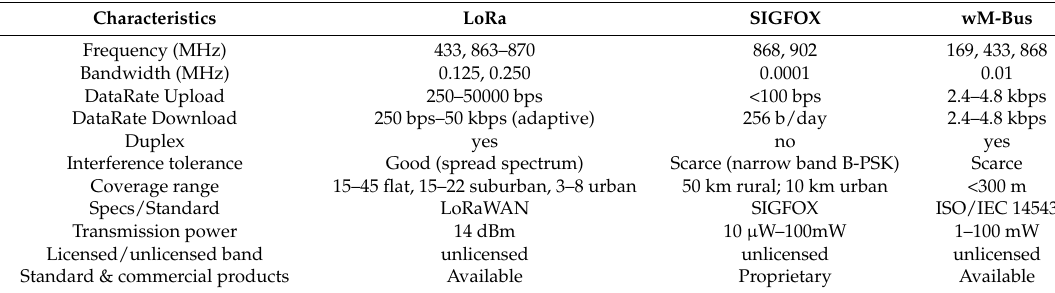
Table 5. Comparison of LoRa, SIGFOX, and wM-Bus